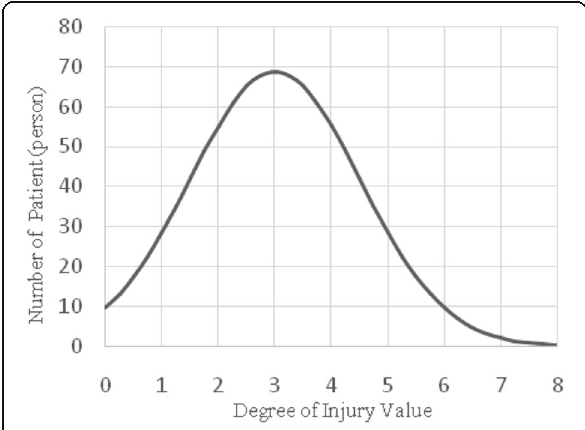
Fig. 2 Histogram Value the Degree of Injury (DIV). Classification of the degree of injury is determined based on the distribution of Degree of Injury Value